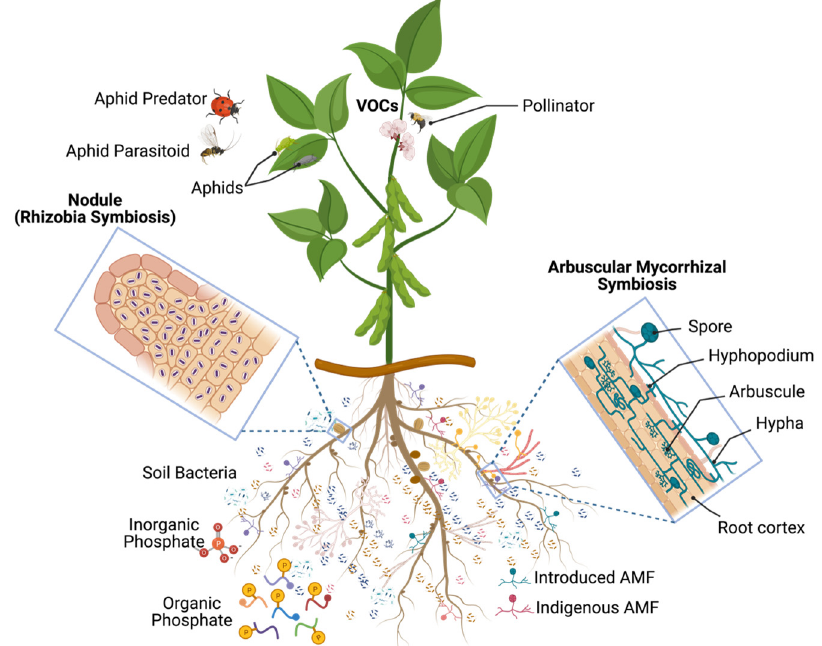
Figure 1. Overview of studies on microbial-based plant biostimulants and trophic cascades of interactions on soybean used as model crop. VOCs, volatile organic compounds; AMF, arbuscular mycorrhizal fungi (Created with BioRender.com).